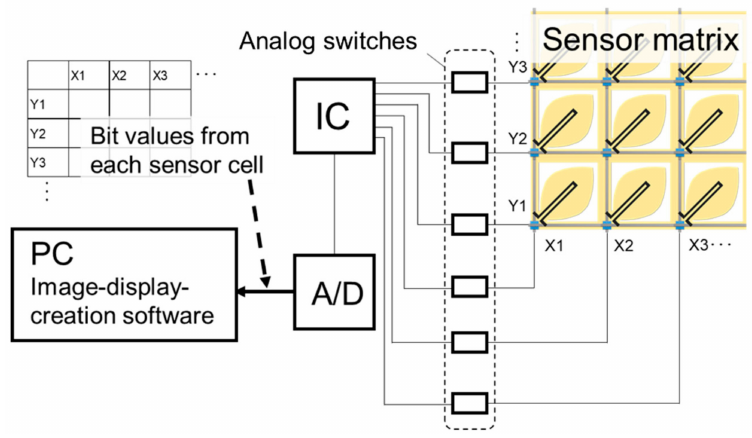
Figure 4. Schematic of the circuit for operating the fabricated sensor